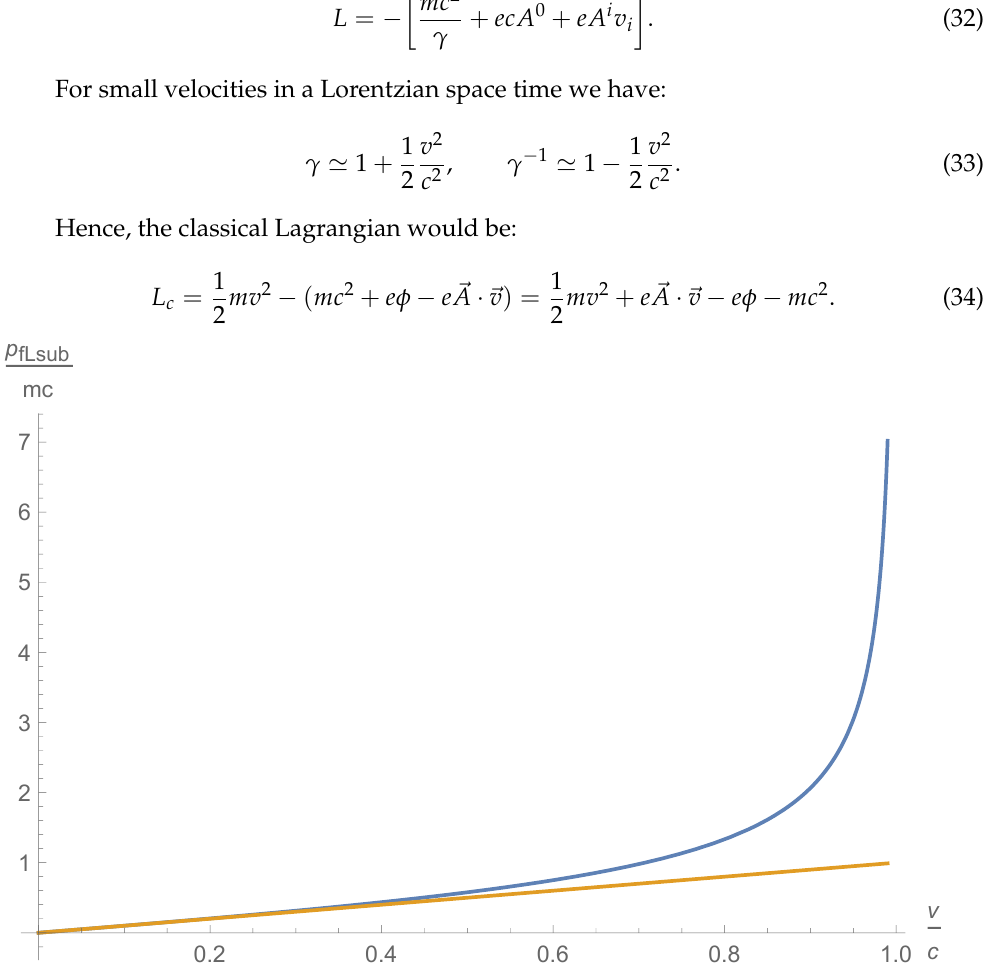
Figure 1. Free momentum for Lorentzian subluminal particles, the correct expression is com- pared to the classical one. The blue line is the correct expression while the orange line is the classical